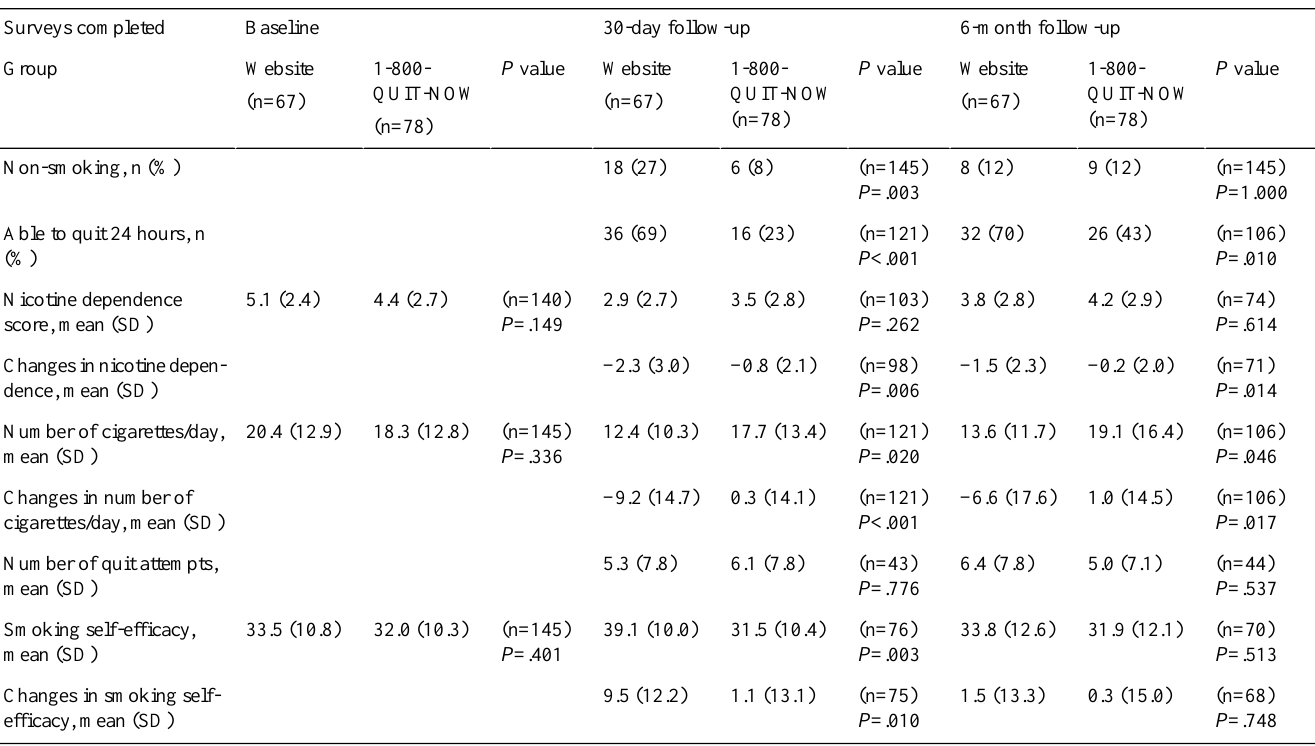
Table 2. Tobacco use among the Tobacco Tactics website and 1-800-QUIT-NOW participants.